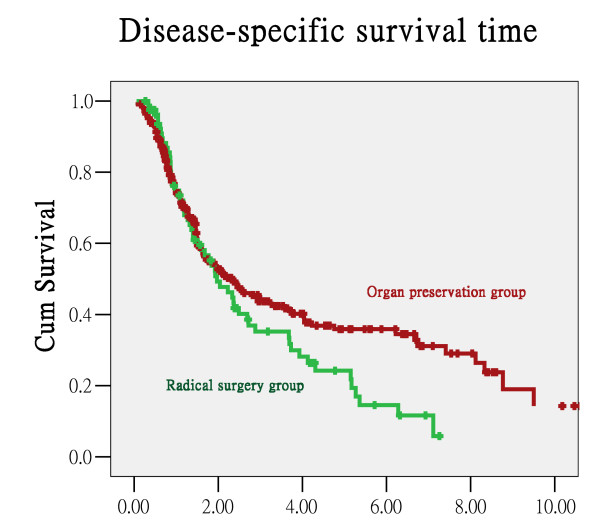
Disease-specific survival curve.